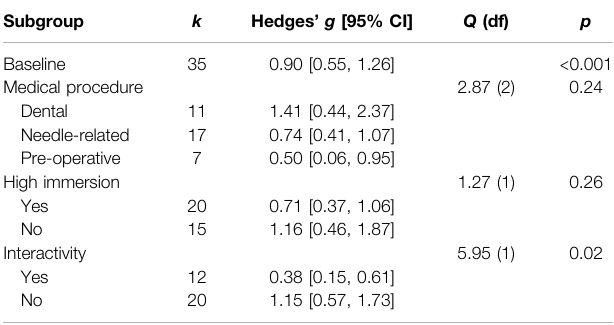
TABLE 7 | Results of meta-regression analysis on the effects of VR on